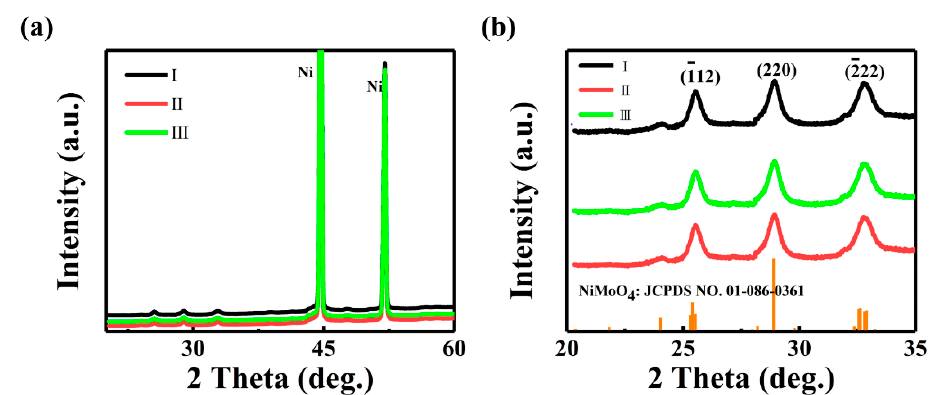
Figure 1. ( a ) X-ray diffraction (XRD) of Sample, Sample II, and Sample III grown on Ni foam; ( b ) Zoom-in view of XRD peaks from 20° to 35°.